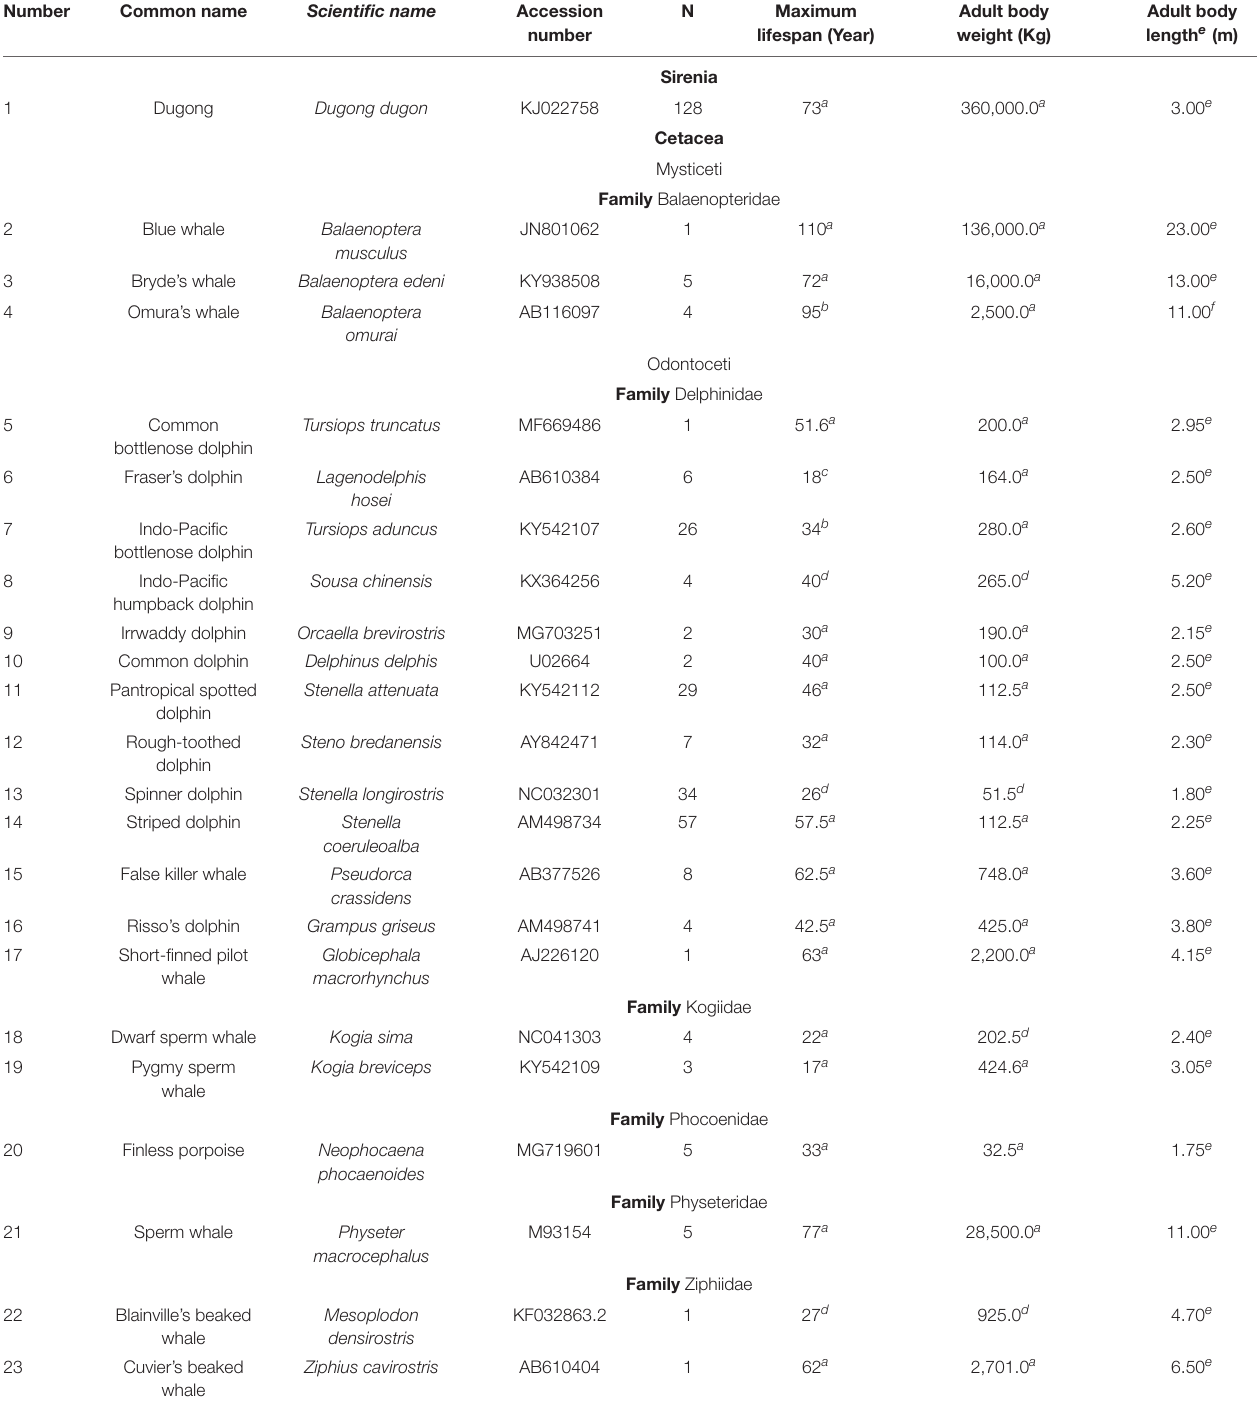
TABLE 1 | Maximum lifespan, adult body weight and length of Sirenia and Cetacea samples used in this